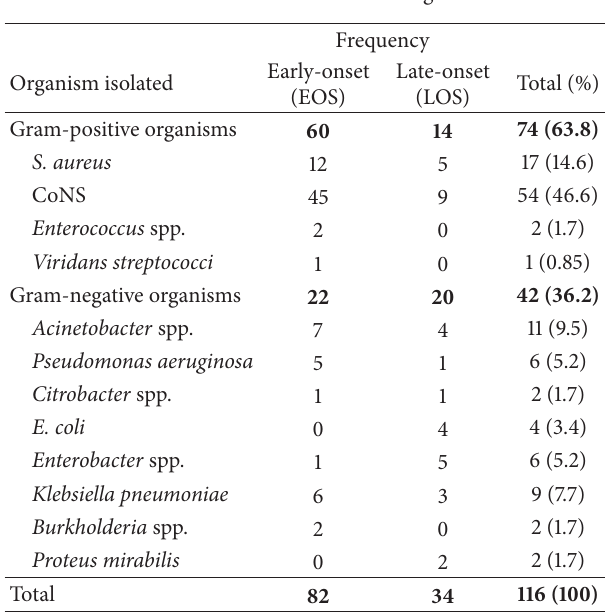
Table 2: Distribution of isolated